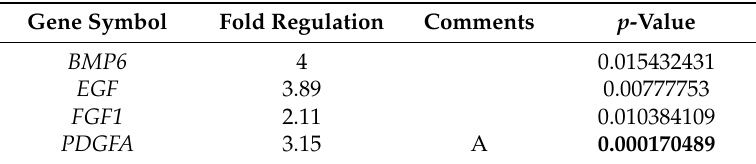
Table 2. Genes up-regulated by CoCl 2 after 24 h by at least a factor of 2 (normalization of C t -values to GAPDH). The significance level was adjusted for multiple testing to 0.0006 (bold p -values are significant), A = in either the control or the test sample, the average C t is high (>30